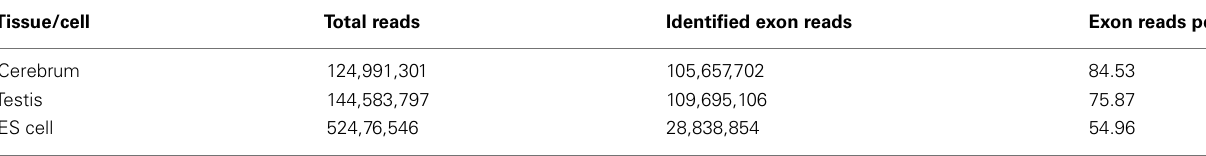
TableA3 |The percentage of exon reads in all mapped reads.